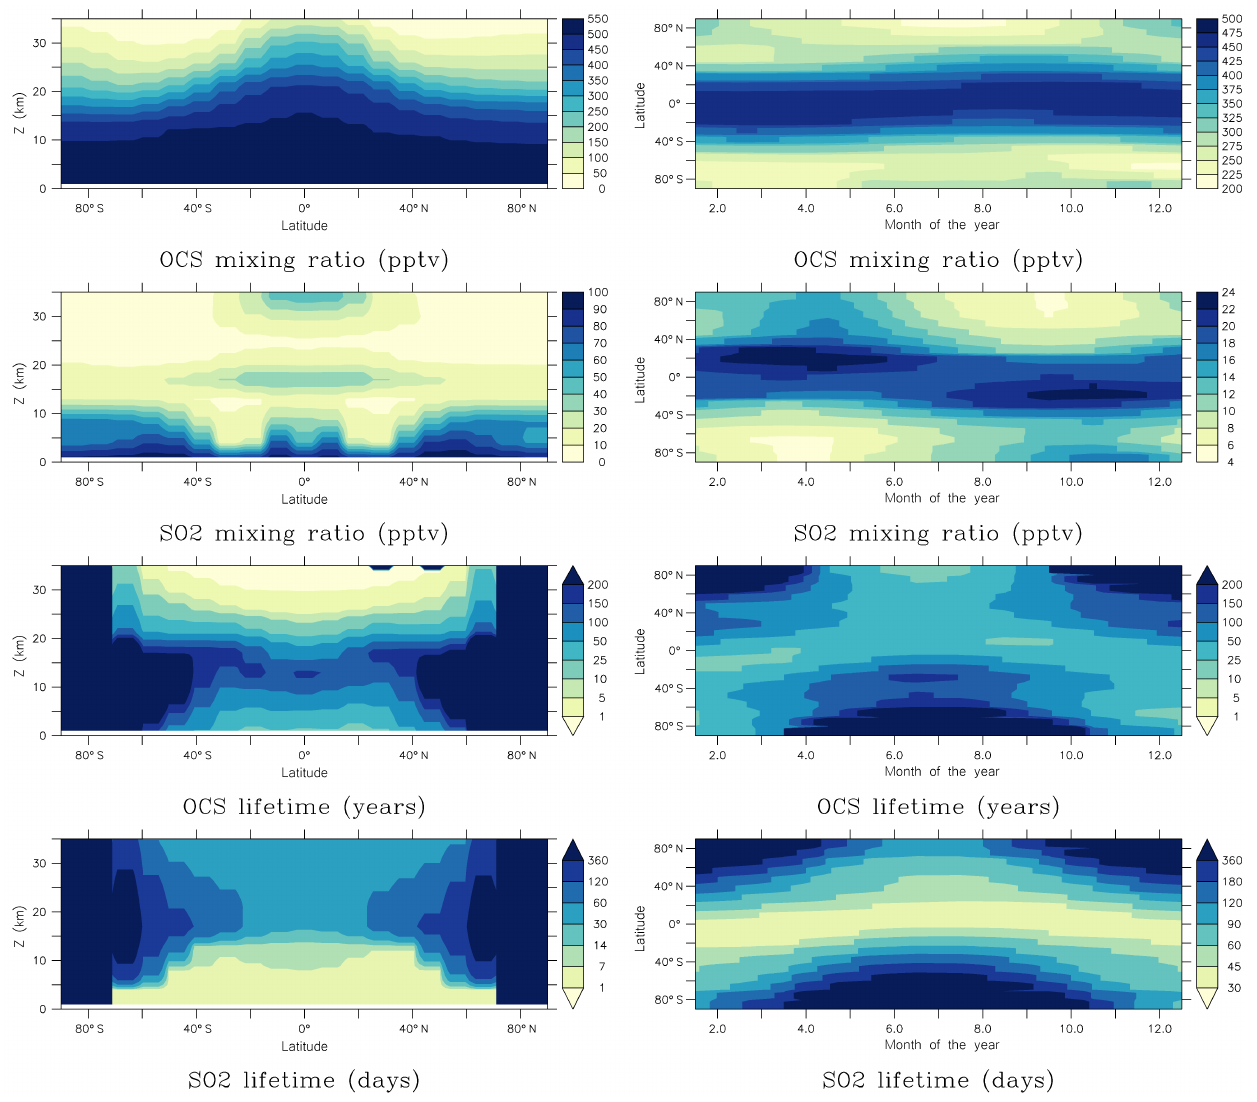
Figure 2. Climatological volume mixing ratios (upper half, in pptv) and lifetimes (lower half, in years or days) of OCS and SO 2 produced by the UPMC/Cambridge model and used as initial and boundary conditions for the LMDZ-S3A model. The left column shows the zonal and annual mean latitude–height distribution, while the right column shows an annual cycle of the zonal mean value at 20km